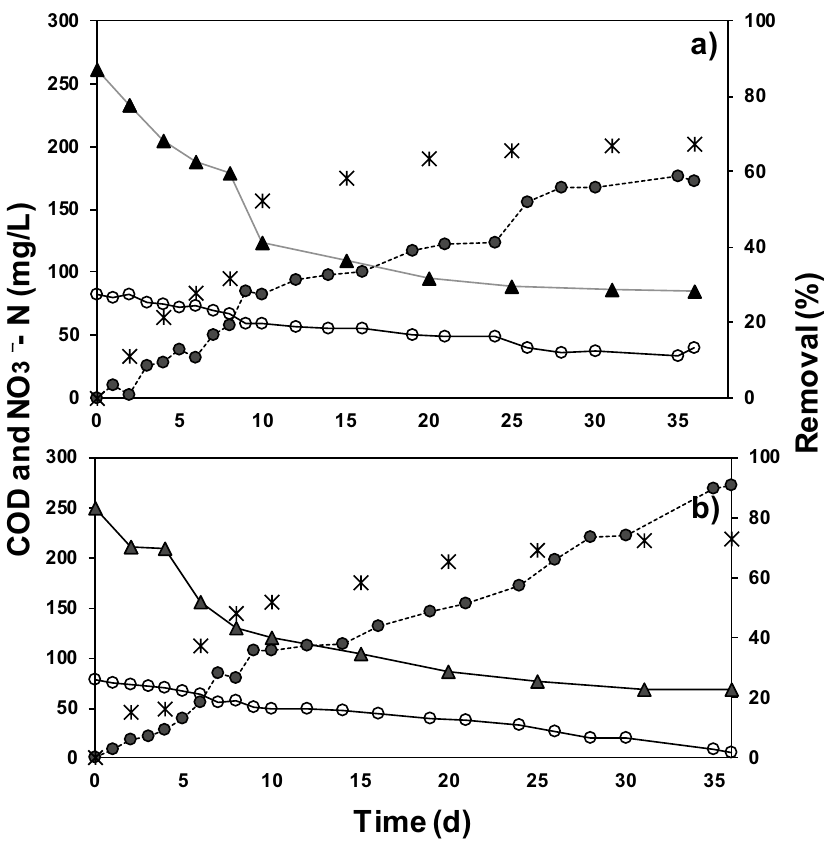
Figure 5. Time chart of consumption behavior NO 3 − N and chemical oxygen demand (COD) during the maximum specific denitrification activity (MSDA) assays for ( a ) R1 and ( b ) R2. Where (filled circle) is the concentration of NO 3 − N; (o) is NO 3 − N removal percentage; (filled triangle) COD concentration (mg/L) and ( ӿ ) is COD removal in the